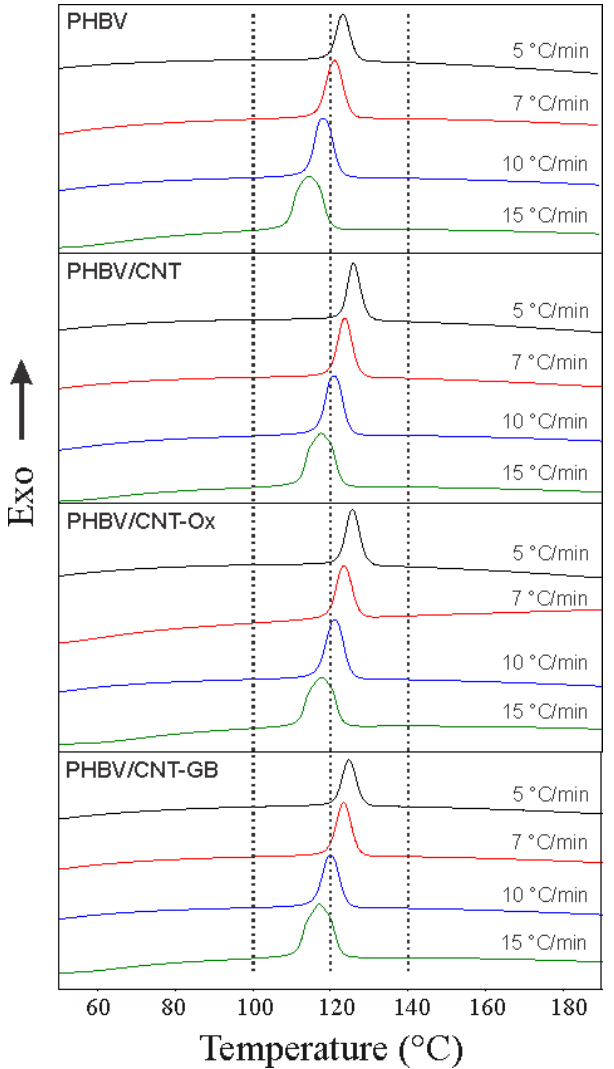
Figure 2. DSC cooling thermograms for PHBV, PHBV/CNT, PHBV/CNT-Ox, and PHBV/CNT-GB (dot lines delimit an interval to facilitate observation of the peak´s shift). Table 2. Summarized DSC results at various cooling rates (5, 7, 10, and 15 °C/min) for PHBV,